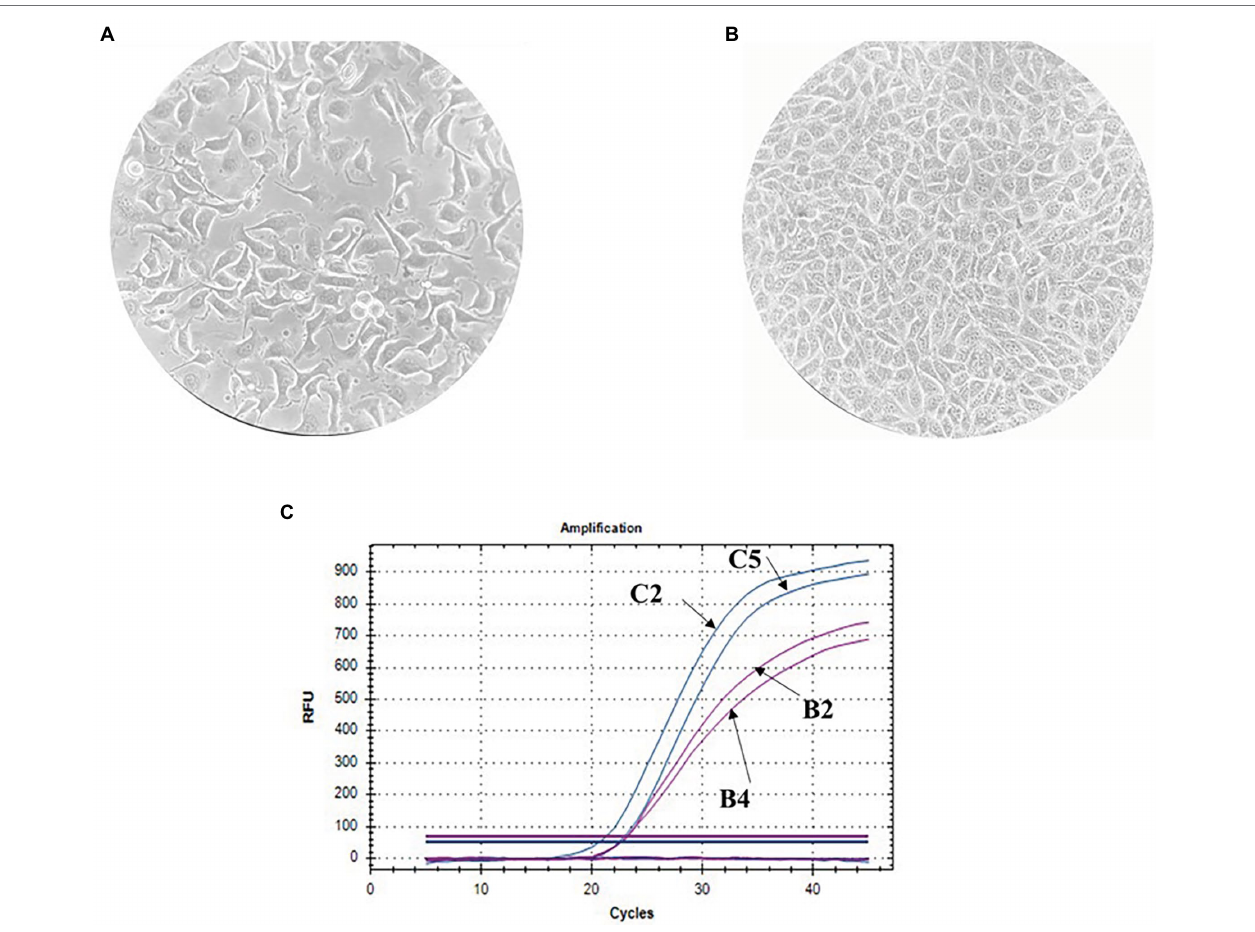
FIGURE 1 | Ovine kidney cell culture (100× magnification) and invasion assay. (A) Propagated cell clusters. (B) Confluent proliferated monolayer. (C) Determination of the cell species by qPCR curves: B2-endogenous control in the sheep kidney cell line (shKEC) cell line, B4-endogenous control in sheep blood, C2-cytb in the shKEC cell line, and C5-cytb in sheep